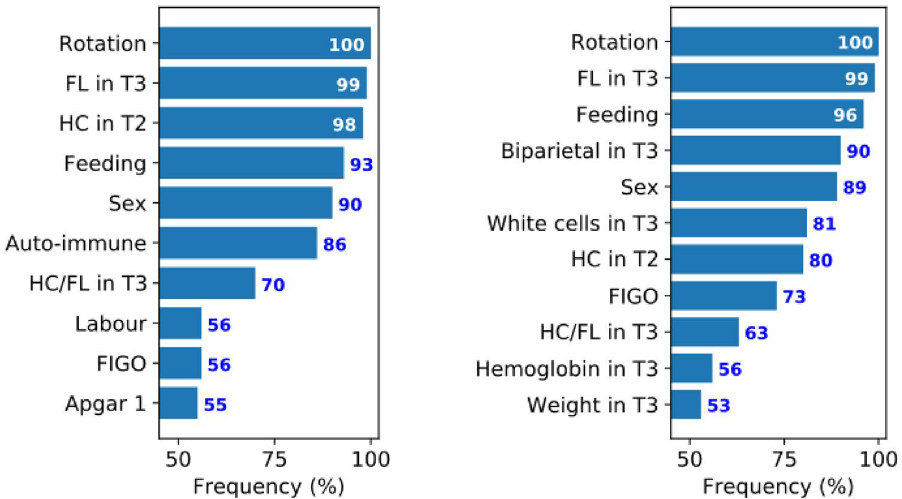
Figure 1. Identification of biomarkers through feature frequency in the cross-validation process. Features that have been selected by the semi-automatic (left plot) and automatic (right plot) feature selection strategies in more than 50 out of 100 folds of the CV process. Features with higher frequencies are more important to the classifier which means they separate better NT babies from ASD ones. T2, second trimester; T3, third trimester; Rotation, timing of fetal rotation on head (days); FL, femur length percentile; HC, head circumference percentile; Feeding, newborn feeding; Auto-immune, familial maternal history of auto-immune diseases; HC/ FL, ratio of head circumference to femur length; Labor, duration of the first part of the labour; FIGO, fetal heart rate during labor (FIGO classification); Apgar 1, Apgar score in 1 min; Biparietal, biparietal diameter percentile; Weight, fetal weight percentile